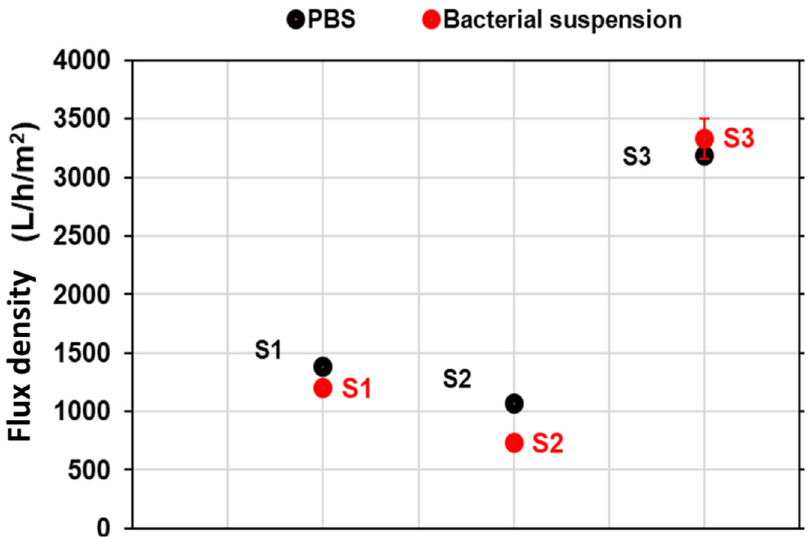
Figure 4. Flux densities with PBS (before filtration of the bacteria) and the bacterial suspension for the bio-based membranes elaborated.